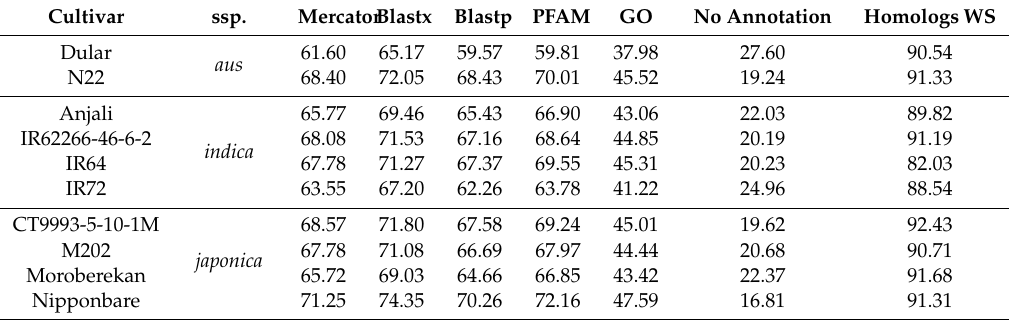
Table 5. Fraction of transcripts (%) for which at least one significant annotation was found by Mercator or the TransDecoder-Trinotate pipeline (blastx, blastp, PFAM or GO). Furthermore, also shown is the percentage of transcripts for which no annotation was reported. All unannotated transcripts (No annotation) were additionally compared with an Oryza wild species cDNA database using blast. The fraction of unannotated transcripts with a highly similar sequence to an Oryza wild species cDNA is shown (Homologs WS). Cultivars were sorted alphabetically within the subspecies (ssp.) aus , indica